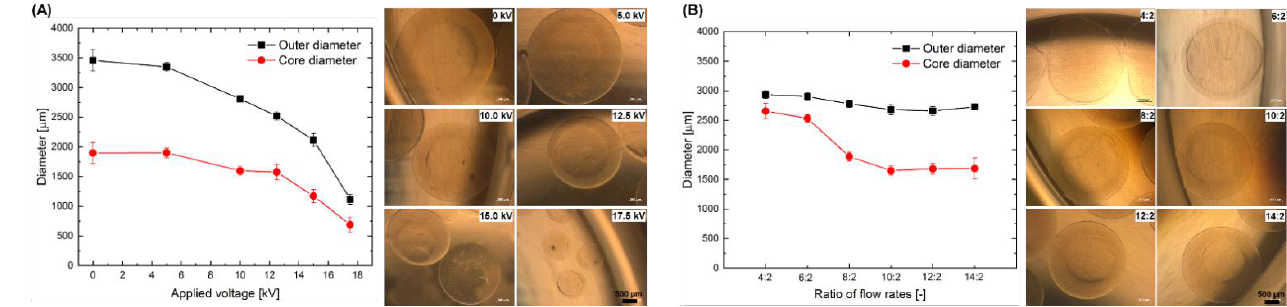
Figure 1. Effect of the applied voltage ( A ) and the ratio of flow rates of alginate to inner fluid ( B ) on the size of the core-shell capsules produced from low viscosity (LV) alginate. Scale bars are 500 µm.